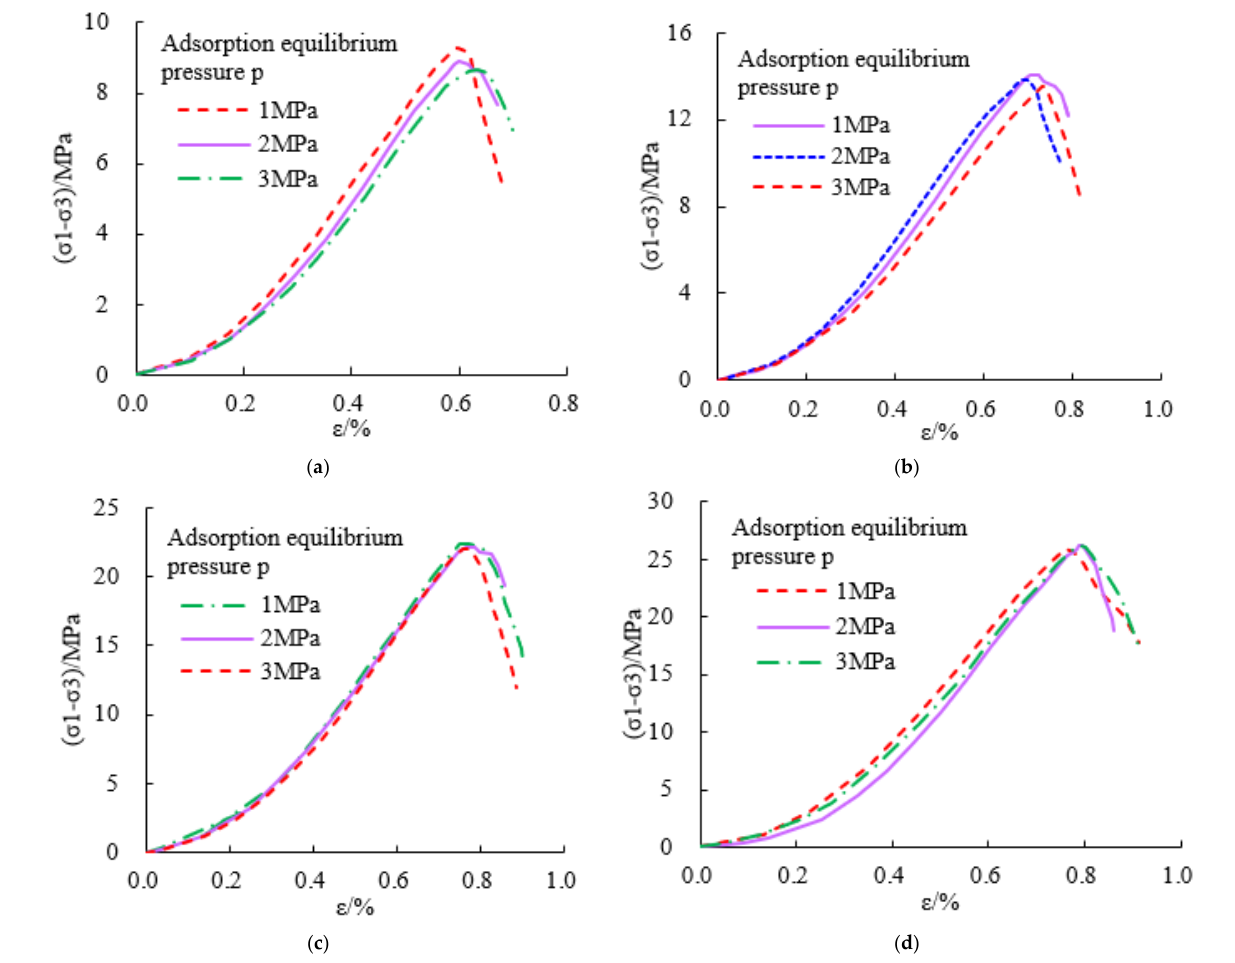
Figure 2. Meager coal triaxial compression stress-strain curve. ( a ) Stress-strain curve of Meager coal when confining pressure is 0 MPa. ( b ) Stress-strain curve of Meager coal when confining pressure is 3 MPa. ( c ) Stress-strain curve of Meager coal when confining pressure is 6 MPa. ( d ) Stress-strain curve of Meager coal when confining pressure is 9 MPa.